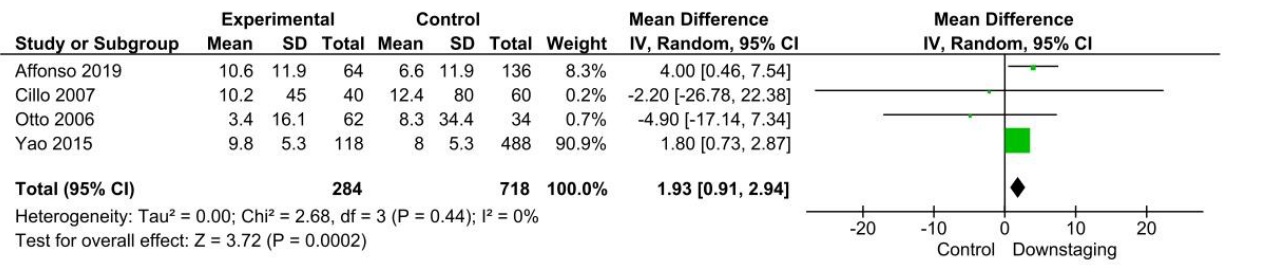
Figure 4. Question 1: Forrest plot post-LT survival: ( A ) 1y-overall survival; ( B ) 3y-overall survival; ( C ) 5y-overall survival. (c)